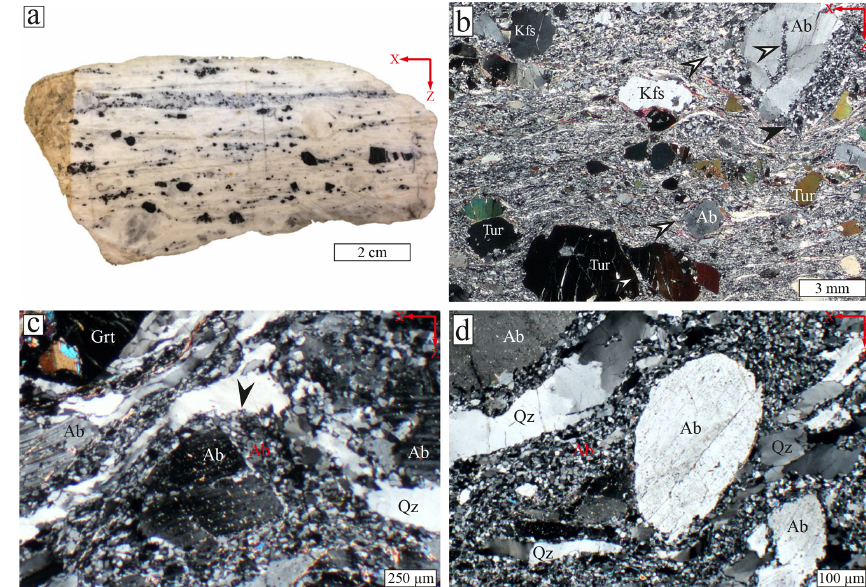
Figure 2. Photograph of polished surface (a) and thin-section micrograph taken with crossed polarizers (b) of sample CT599. K-feldspar (Kfs), albite (Ab) and tourmaline (Tur) porphyroclasts are embedded in a fine-grained matrix. Elongated fractured tourmaline crystals are oriented with their long axes parallel to the stretching lineation ( x ). Fractures are commonly oriented at a high angle to the stretching lineation ( z ). Arrows point to strain shadows surrounding porphyroclast and prismatic strain shadows between fragments of tourmaline and feldspar. Black arrow points to mylonitic foliation flowing around strain shadow. (c, d) Polarized light micrographs (crossed polarizers, sample FH5b) showing mylonitic foliation defined by quartz layers (Qz) flowing around garnet (Grt) and albite porphyroclasts (Ab), which are partly disintegrated into a fine-grained albite matrix.